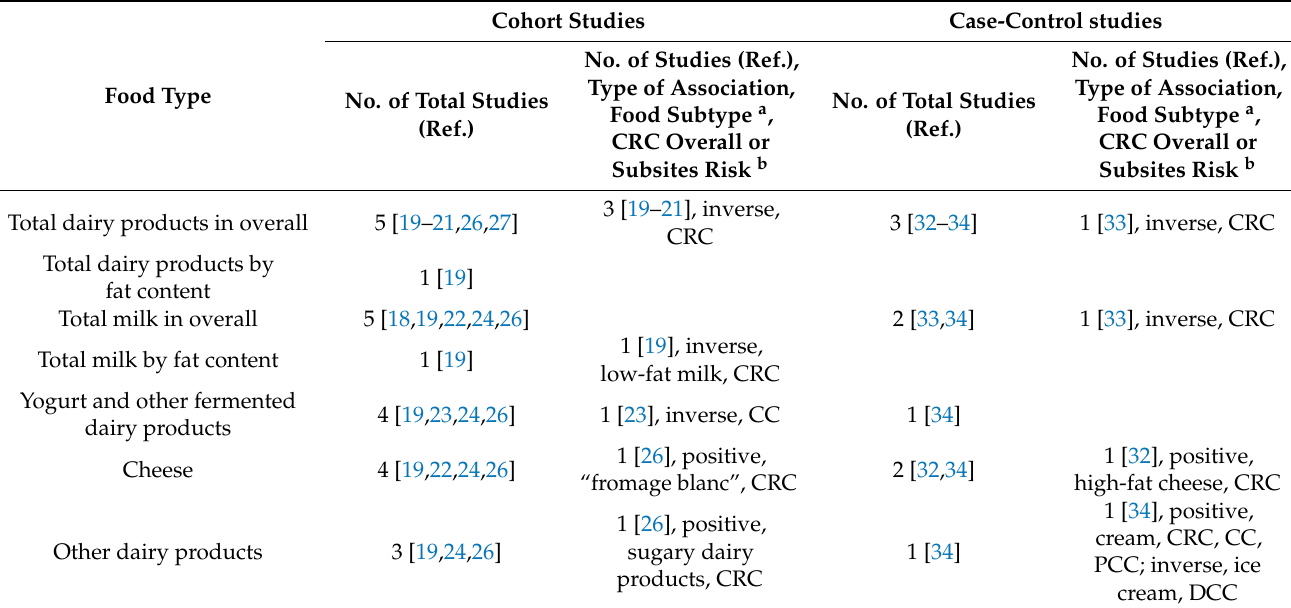
Table 3. Summary of the findings found in the reviewed articles examining the association between the consumption of dairy products and the risk of colorectal